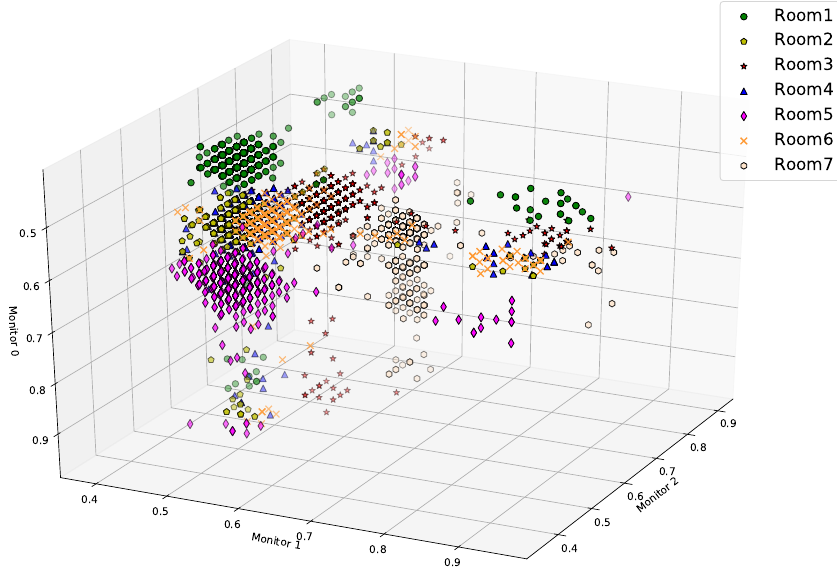
Figure 8. Raw RSSI